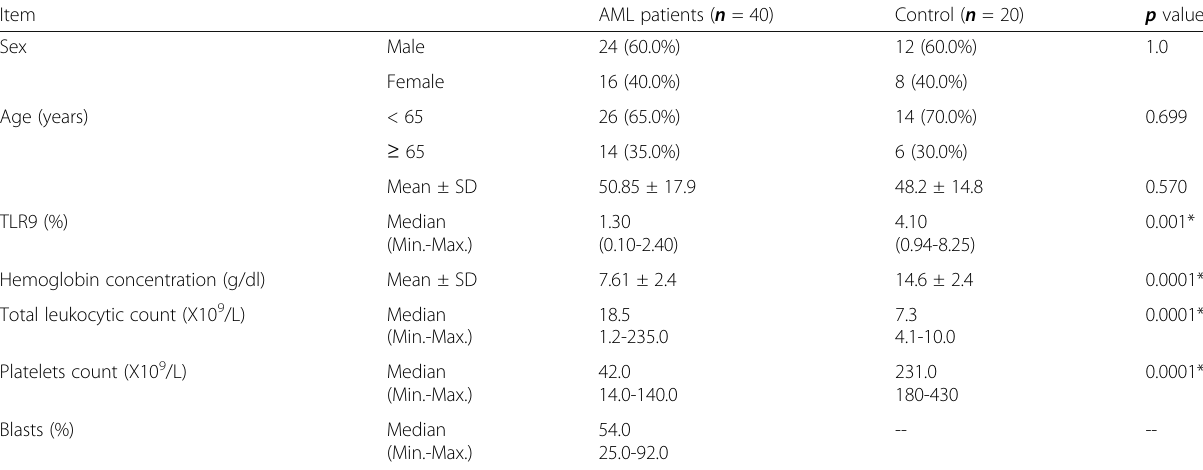
Table 1 Sex, age, TLR9 expression, and some laboratory parameters of the studied patients with acute myeloid leukemia compared to the